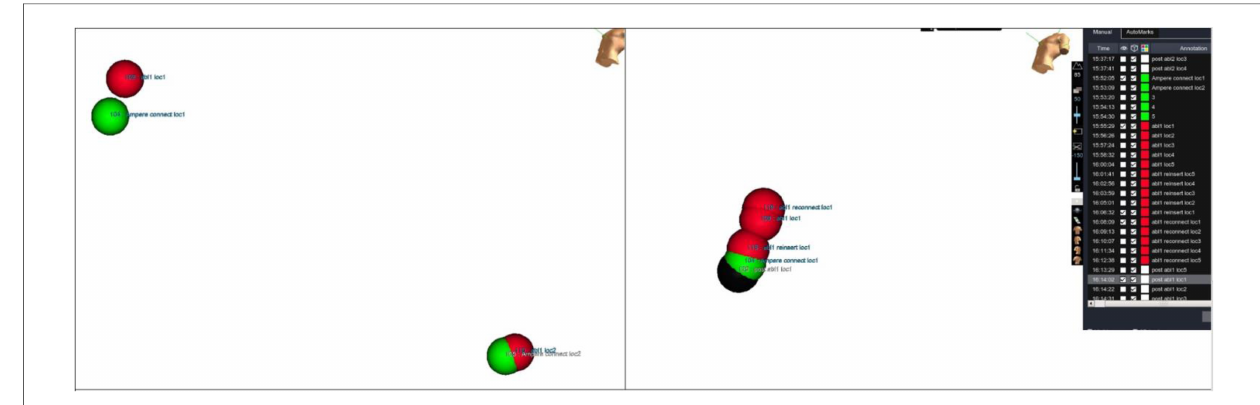
FIGURE 5 Accuracy measurements. Distance measurements between tags collected at same location during different moments of evaluation. Tip location has been tagged at each testing step and then distance has been